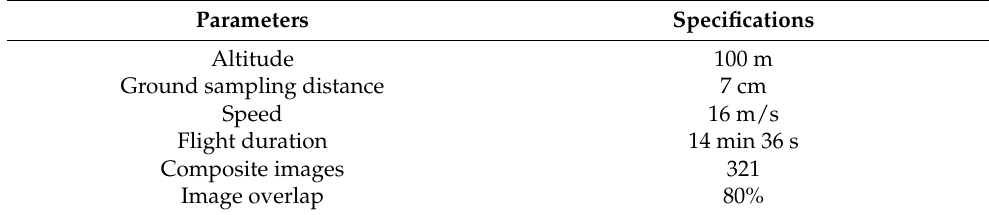
Figure 4. ( a ) DJI M-300 flight plan, ( b ) MicaSense Altum calibration reflectance panel.